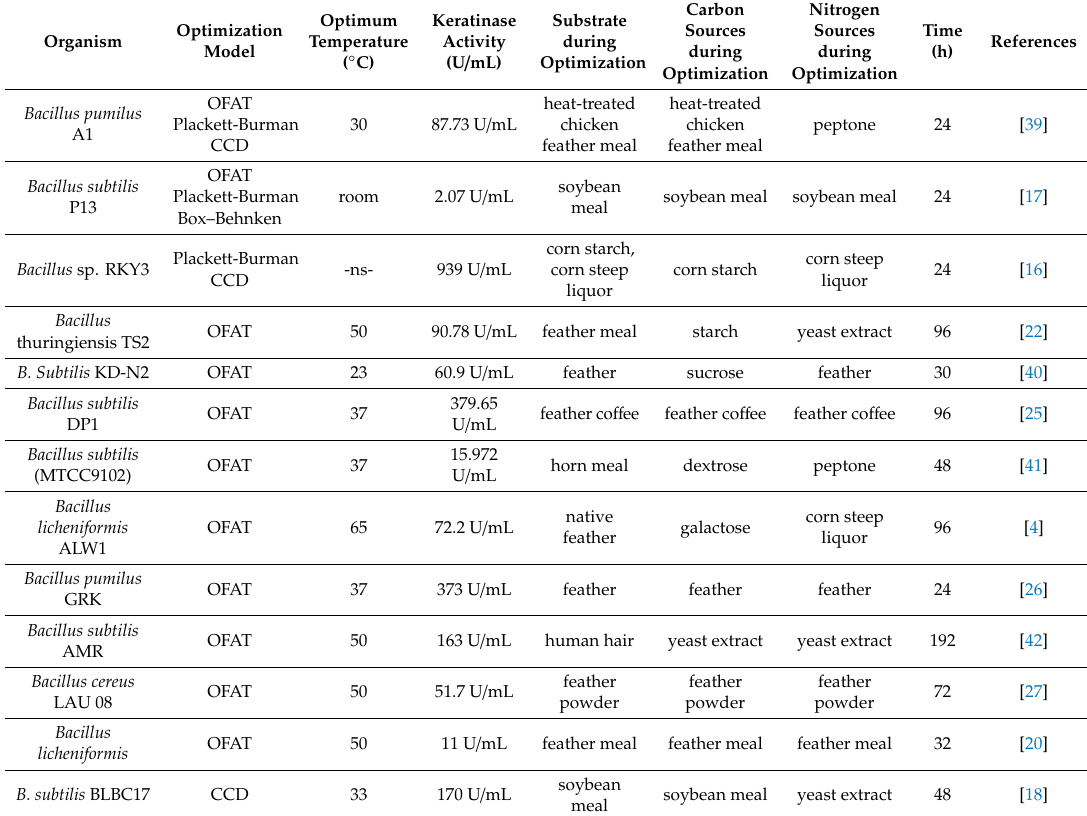
Table 7. Summary of keratinase production by Bacillus